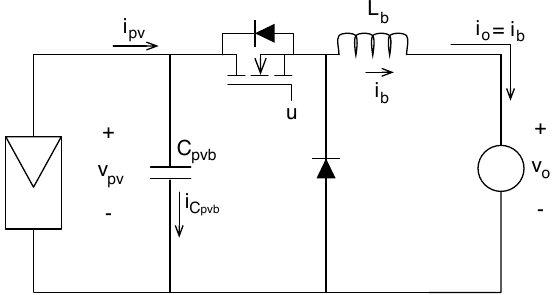
Figure 5. PV system based on the classical buck